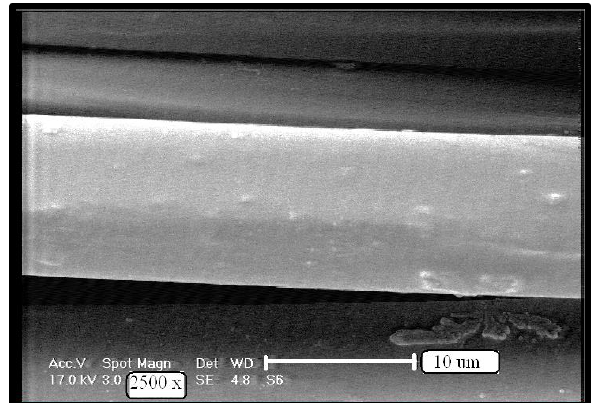
Figure 4 . SEM observation of poly (ethylene terephthalate) knitted material